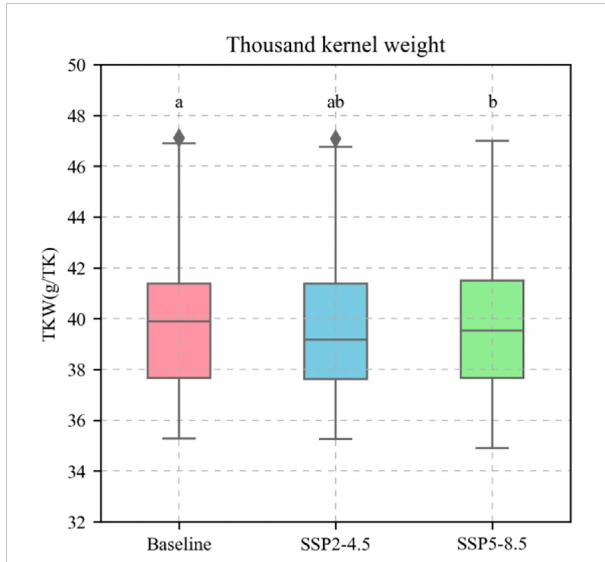
FIGURE 11 Thousand kernel weight (TKW) of 81 wheat varieties during phenological stages under different climate scenarios. The red boxes represent the Baseline; The blue boxes represent SSP2-4.5; The green boxes represent SSP2-8.5. The different letters indicate signi fi cance at the 0.05